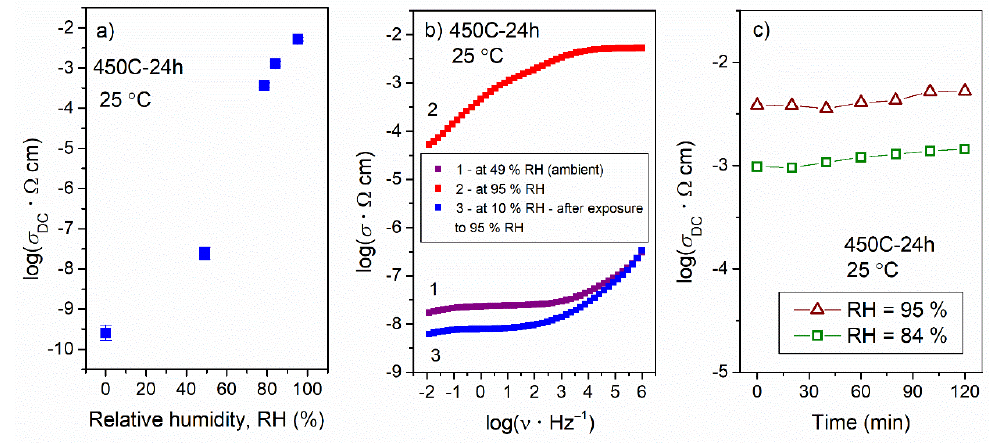
Figure 5. ( a ) DC conductivity at room temperature as a function of relative humidity (RH), ( b ) recovery experiment: 1st measurement—conductivity spectrum at RH = 49% (ambient), 2nd measurement—conductivity spectrum at RH = 95% for 2 h and 3rd measurement—conductivity spectrum at RH ≈ 10% recorded 12 h after exposure to high humidity and ( c ) time-dependent conductivity at RH = 84% and 95% for glass-ceramics prepared at 450 °C for 24 h. Note that the strong electrode polarization effect in the conductivity spectrum measured at RH = 95% (Figure b) is due to proton conductivity, i.e., blocking of protons at the surface of the electrode.